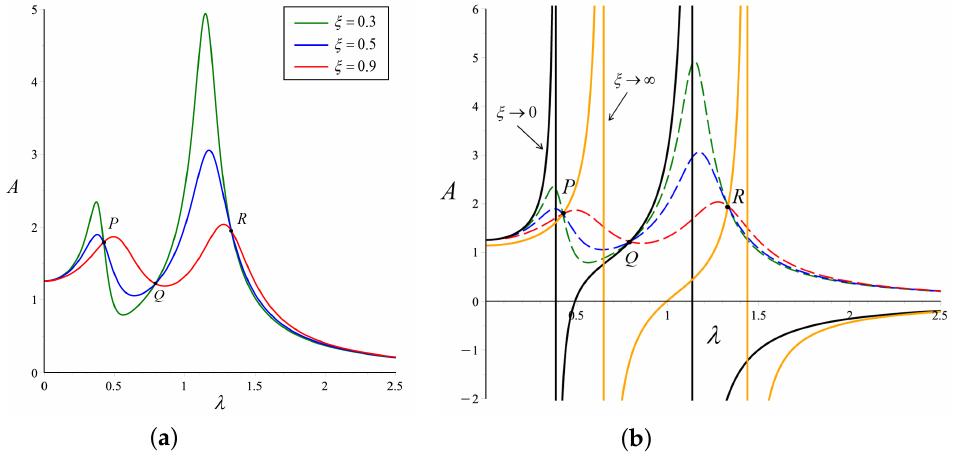
Figure 2. The normalized amplitude–frequency curves under different damping ratios: ( a ) ξ = 0.3, ξ = 0.5, and ξ = 0.9; ( b ) ξ → 0 and ξ → ∞